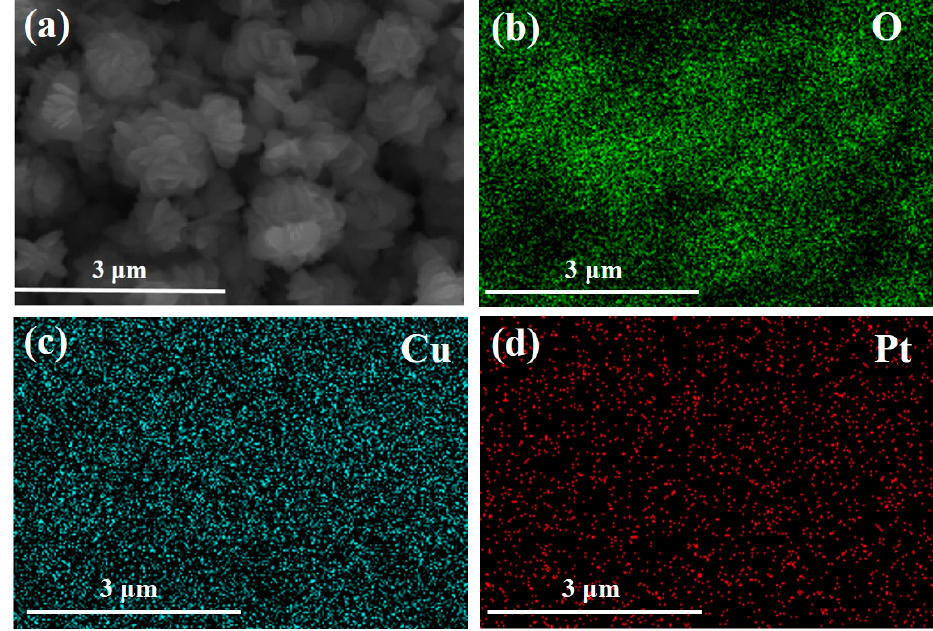
Figure 4. Energy Dispersive X-Ray (EDX) element mapping of 1.25 wt % Pt-doped CuO structure, as follows: ( a ) 1.25Pt-CuO, ( b ) O, ( c ) Cu, and ( d ) Pt.